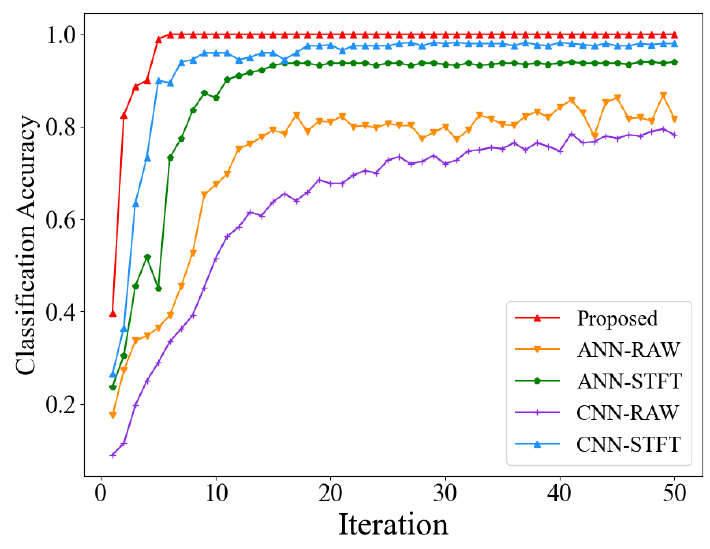
Figure 13. The classification accuracy between proposed and compared methods on DUT